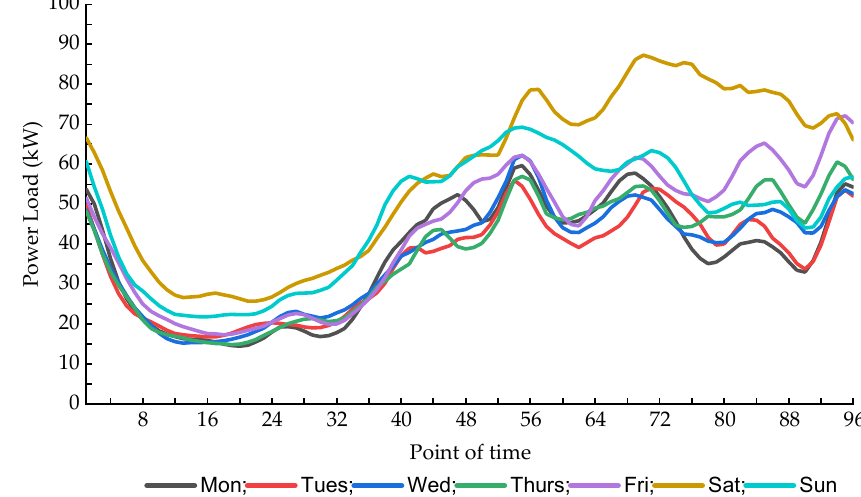
Figure A3. Average daily electric vehicle charging load for different weeks.